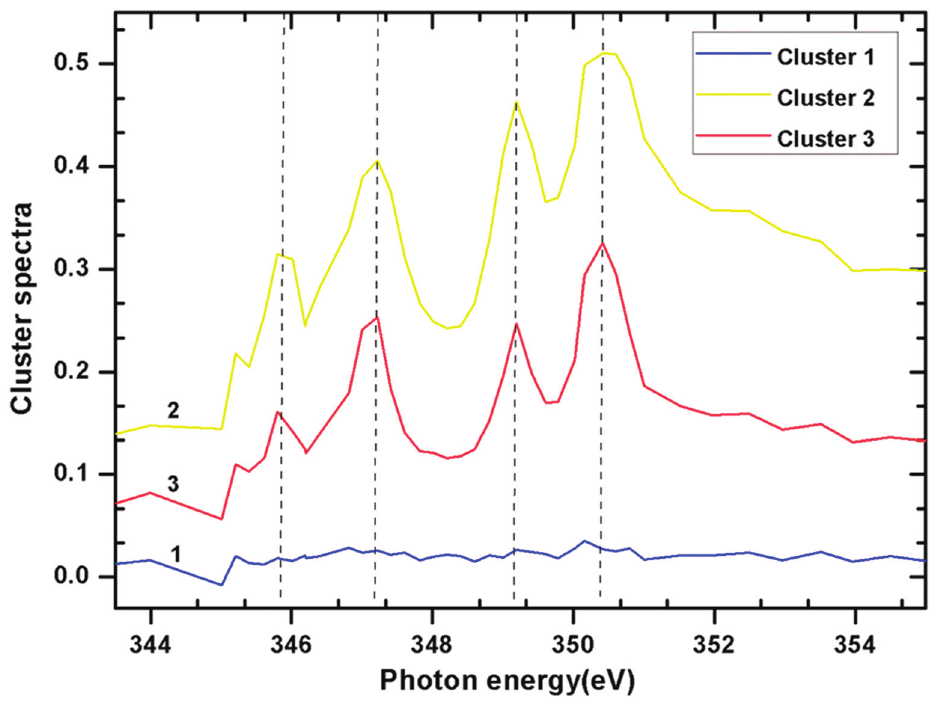
Figure 6. NEXAFS spectra of total Ca in P. carterae by cluster measurements of images as showed in Figure